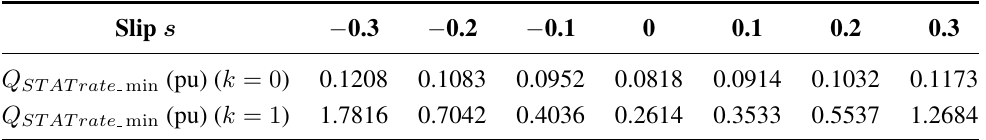
Table 4. Minimum capacity required for the STATCOM with different